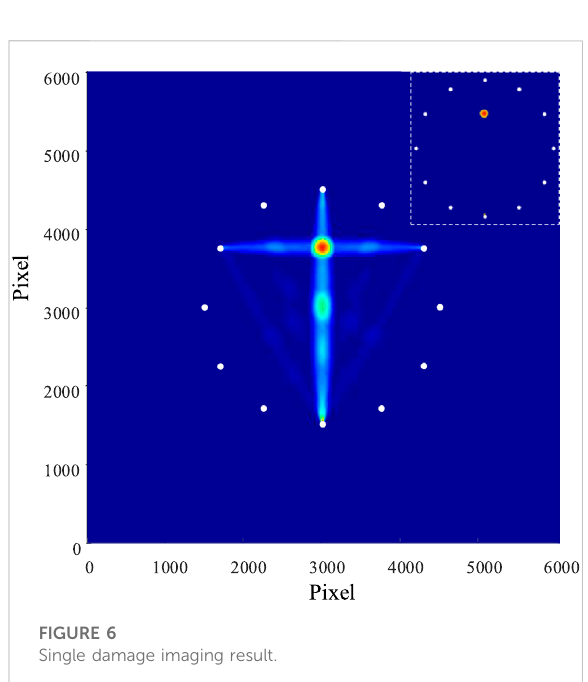
FIGURE 6 Single damage imaging